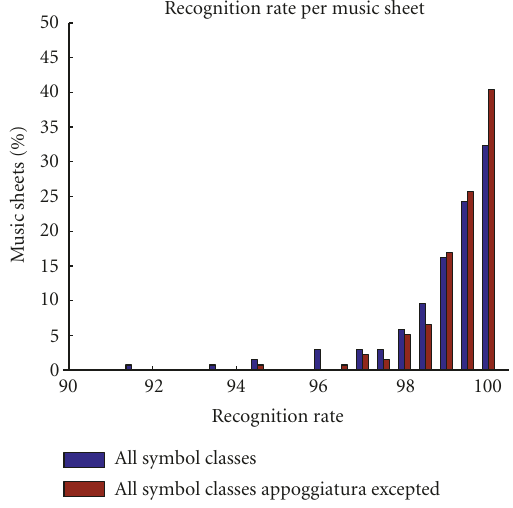
Figure 18: Histogram of the recognition rates obtained per music